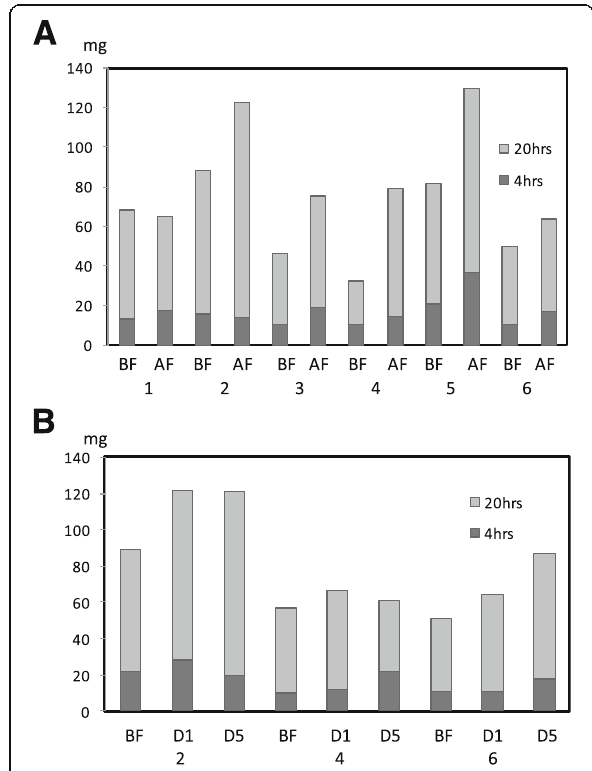
Fig. 4 Changes in the amount of excreted total aceneuramic acid in urine (Trial-1). Urine was collected in periods of − 24 to 20 h and - 20 to 0 h (before administration), 0 to 4 h and 4 to 24 h (after administration). The amount of excreted total aceneuramic acid was compared between before and after administration. In single and three times per day administration, the amount of excretion for 24 h increased after administration in all but one subject (subject number 1). In 5-day administration, the total aceneuramic excretion of 24 h increased after administration. a . Single administration (subject numbers 1 to 3), Three-times-per-day administration